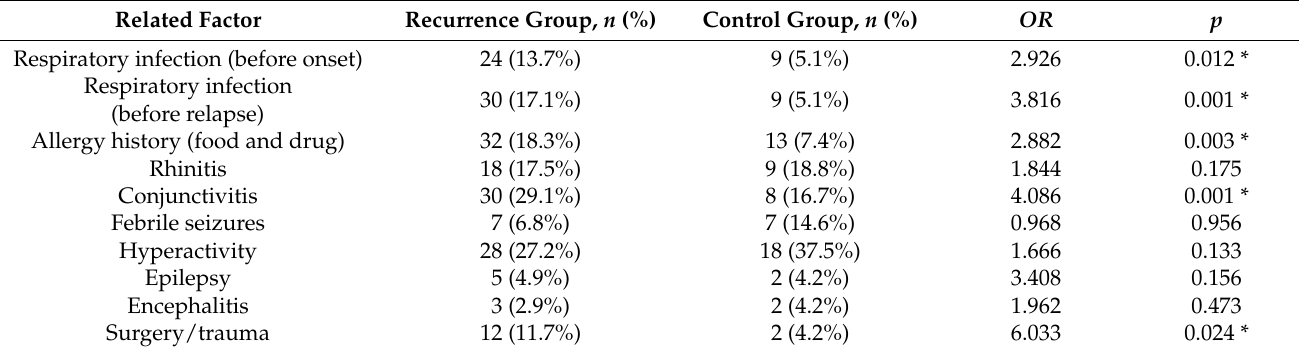
Table 3. Correlation of other diseases and allergic factors with tic recurrence (modifiable